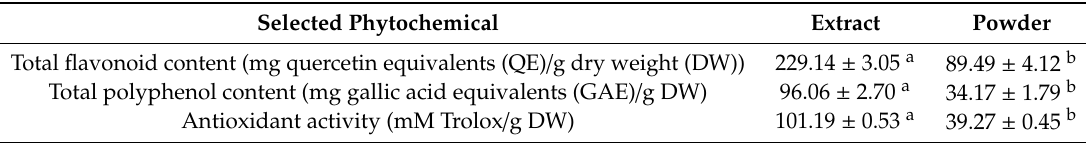
Table 1. The extract and powder phytochemical characterization. Selected Phytochemical Extract Powder Total flavonoid content (mg quercetin equivalents (QE) / g dry weight (DW)) Total polyphenol content (mg gallic acid equivalents (GAE) / g